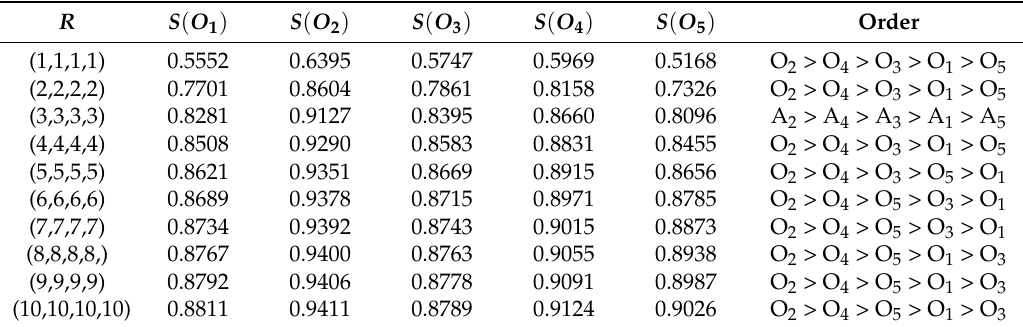
Table 4. Order for different parameters of DGSVNNWBM.